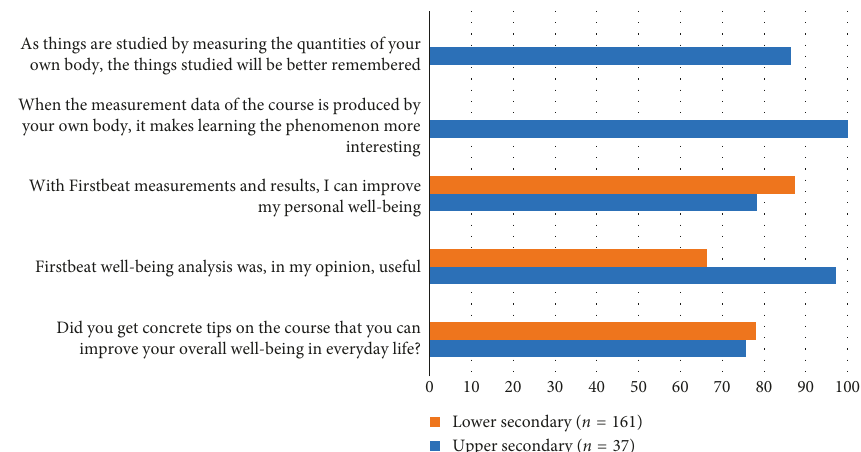
Figure 2: Percentages of the students’ positive answers to the